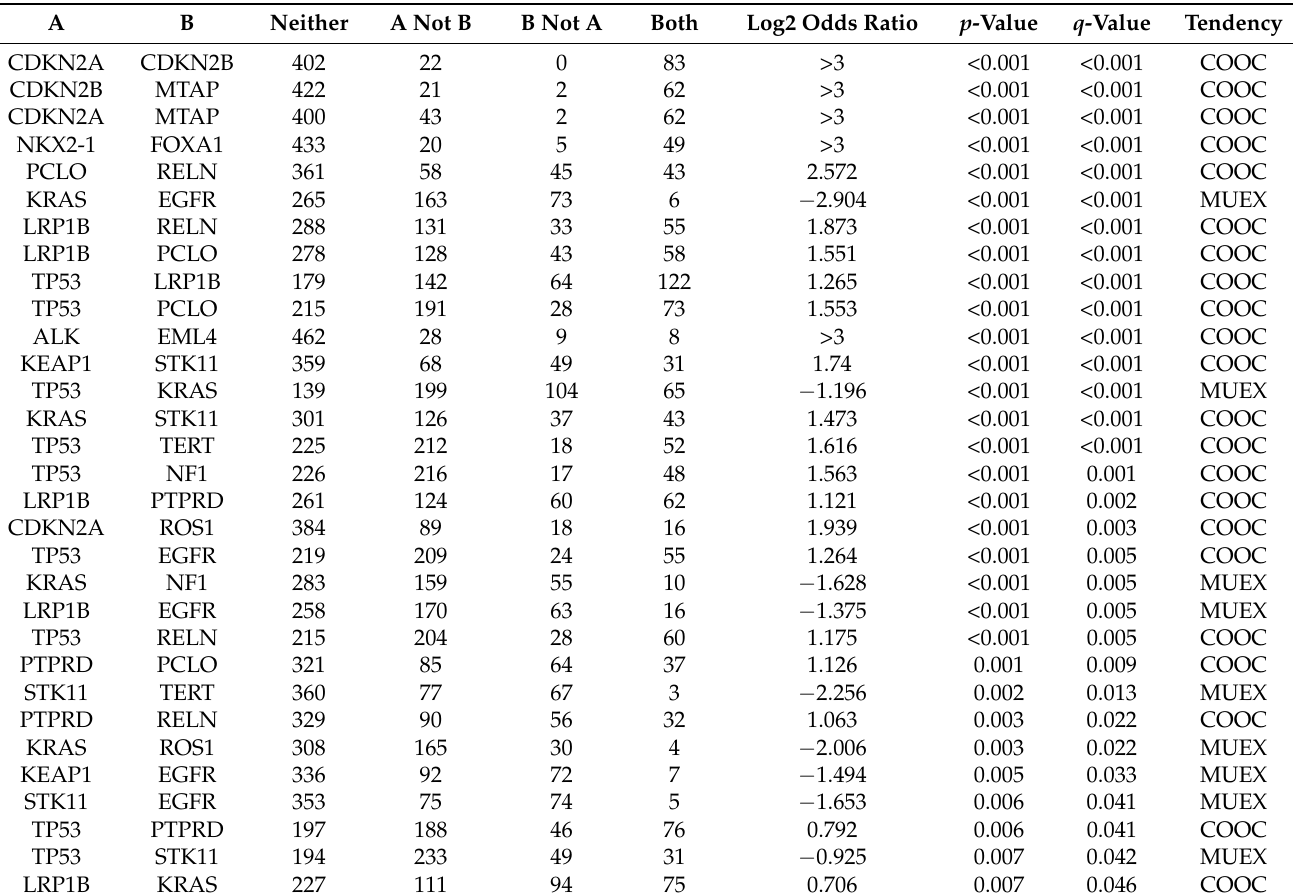
Table 1. Mutual exclusivity and co-occurrence of frequently altered cancer genes in the TCGA pan-cancer LUAD dataset ( n = 507). Queried genes were frequently mutually exclusive (MUEX; indicating dominant oncogenes) or co-occurring (COOC; indicating oncogene addiction). p , probability, hypergeometric test; q , probability, false discovery rate. Data are from https://www.cbioportal.org/study/summary?id=luad_tcga_pan_can_atlas_2018